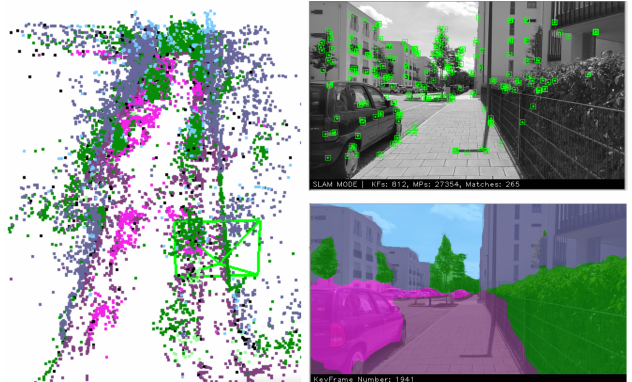
Figure 2. It is possible to identify in the 3D maps trees, cars, and buildings, while also seeing the current frame with the tracked keypoints and the semantic segmentation of the last